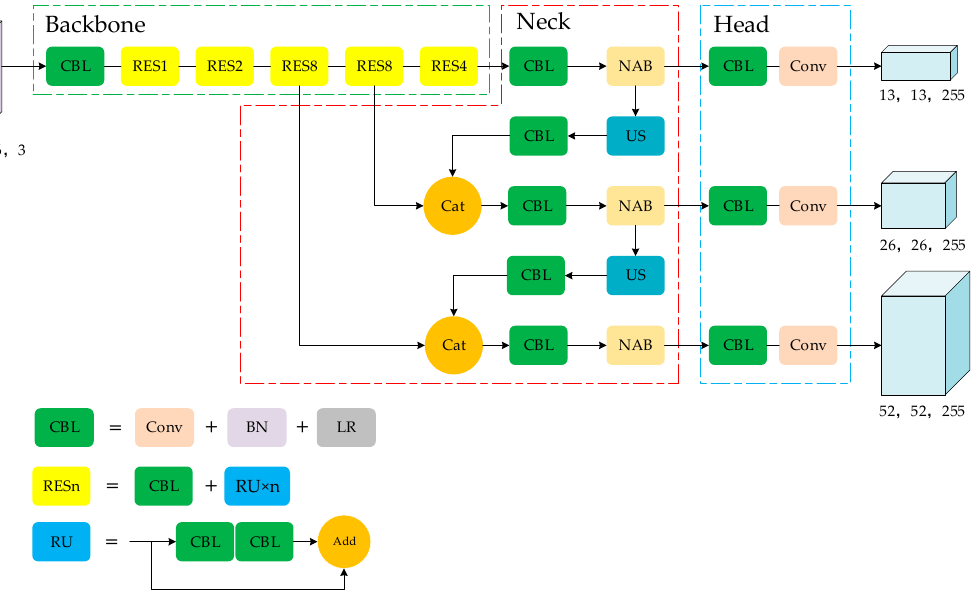
Figure 4. The network of the improved YOLOv3. It can be divided into the backbone, called Darknet53; the neck, which contains FPN and NAB; and the head, which is composed of two convolutional layers. ‘Cat’ and ‘US’ denote the operations of concat and up-sampling, respectively. ‘LR’ is the abbreviation of Leaky ReLU.